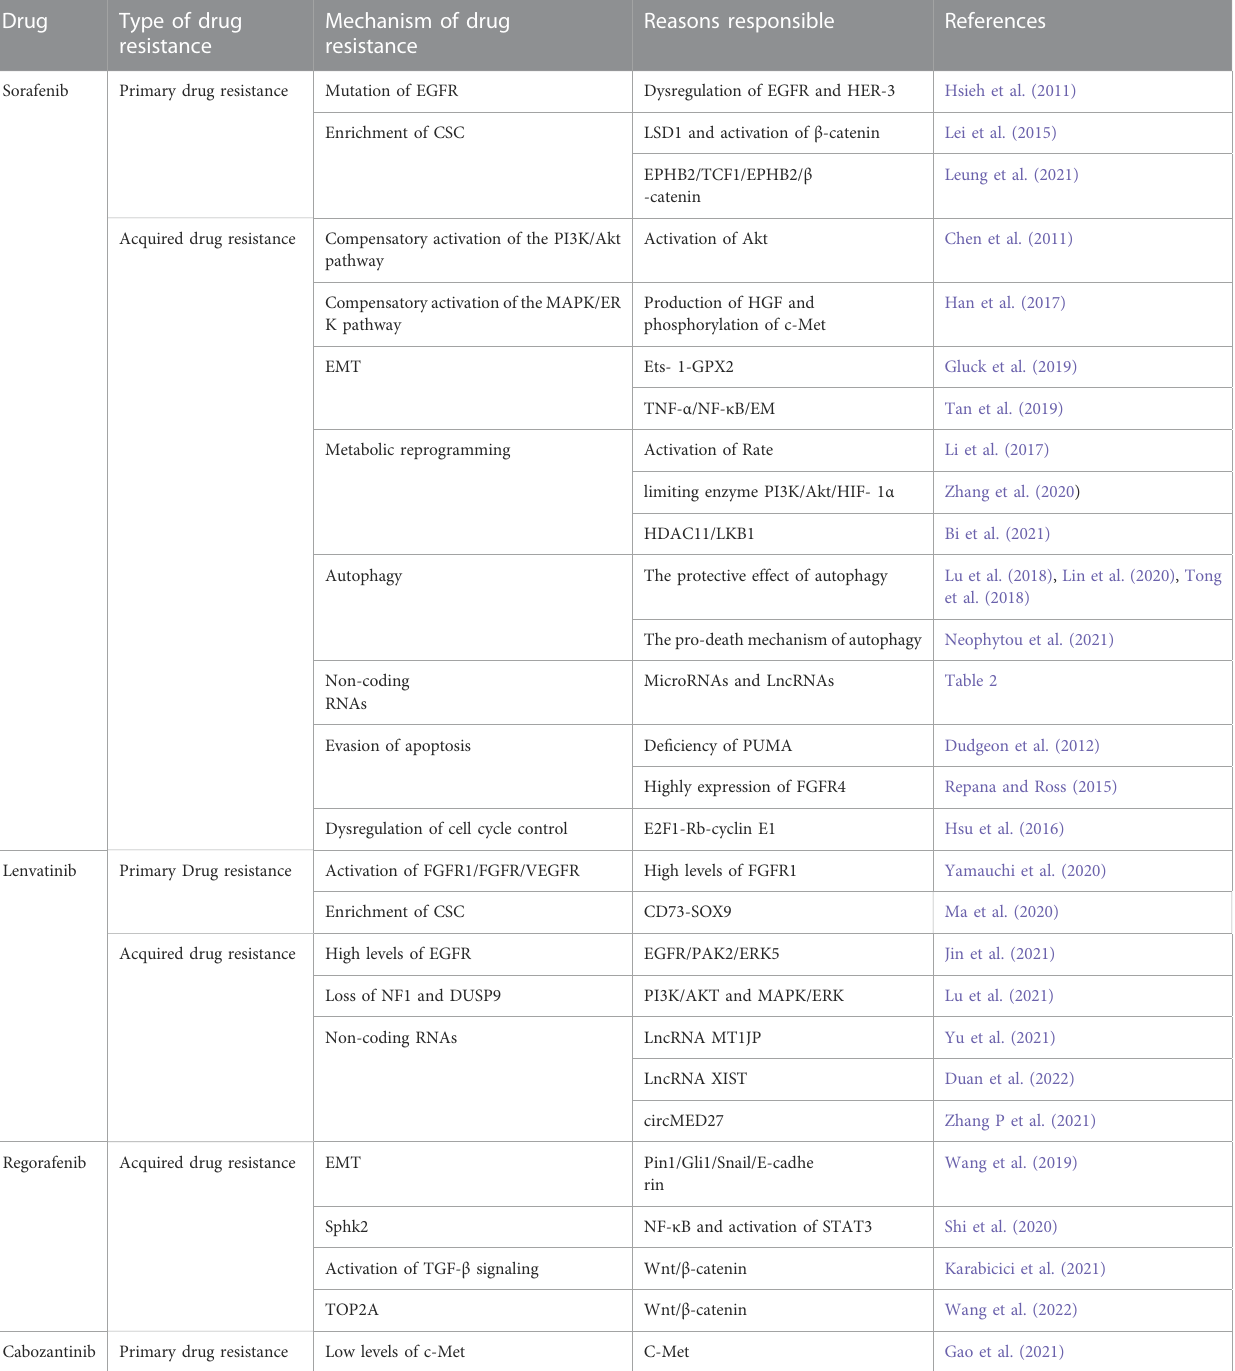
TABLE 1 Summary of previous studies with the mechanisms of receptor tyrosine kinase drug resistance in